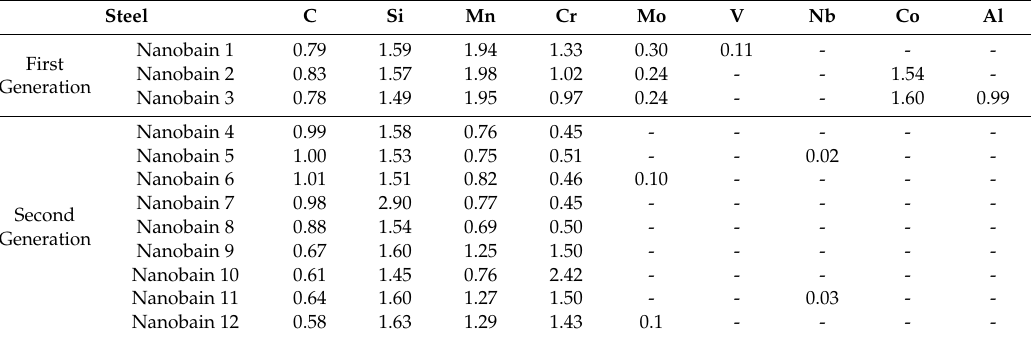
Table 1. Chemical composition of nano-grained bainitic steels, wt.%. [10]. Steel C Si Mn Cr Mo V Nb Co